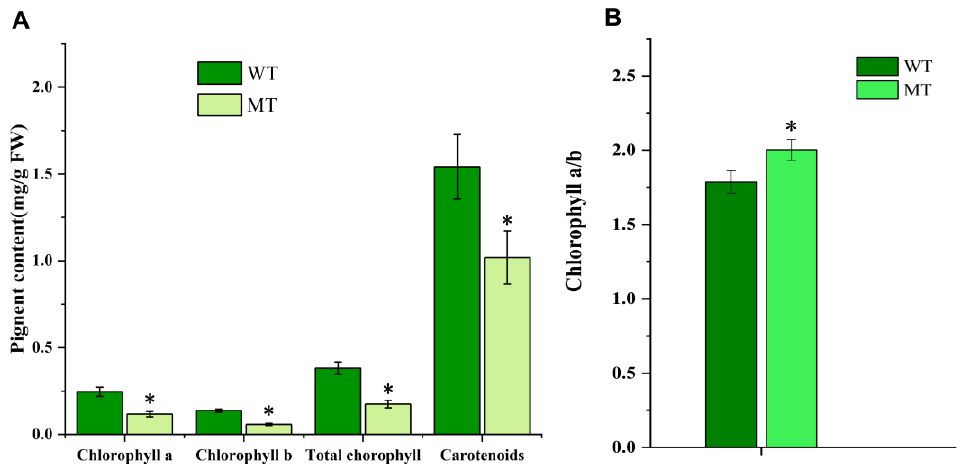
Figure 3. Comparison of photosynthetic pigments in leaves of mutant (MT) and wild-type plants (WT). ( A ) Contents of photosynthetic pigments in leaves of MT and WT; ( B ) the ratio of chlorophyll a to chlorophyll b in MT and WT. * indicates significant differences ( p < 0.05).